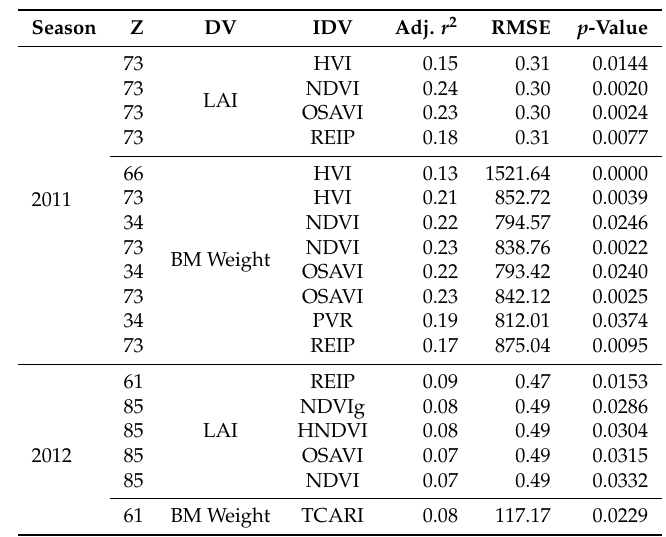
Table 5. Linear regression analysis of UAV MMS1 sensor indices for site-years 2 and 3. Z =